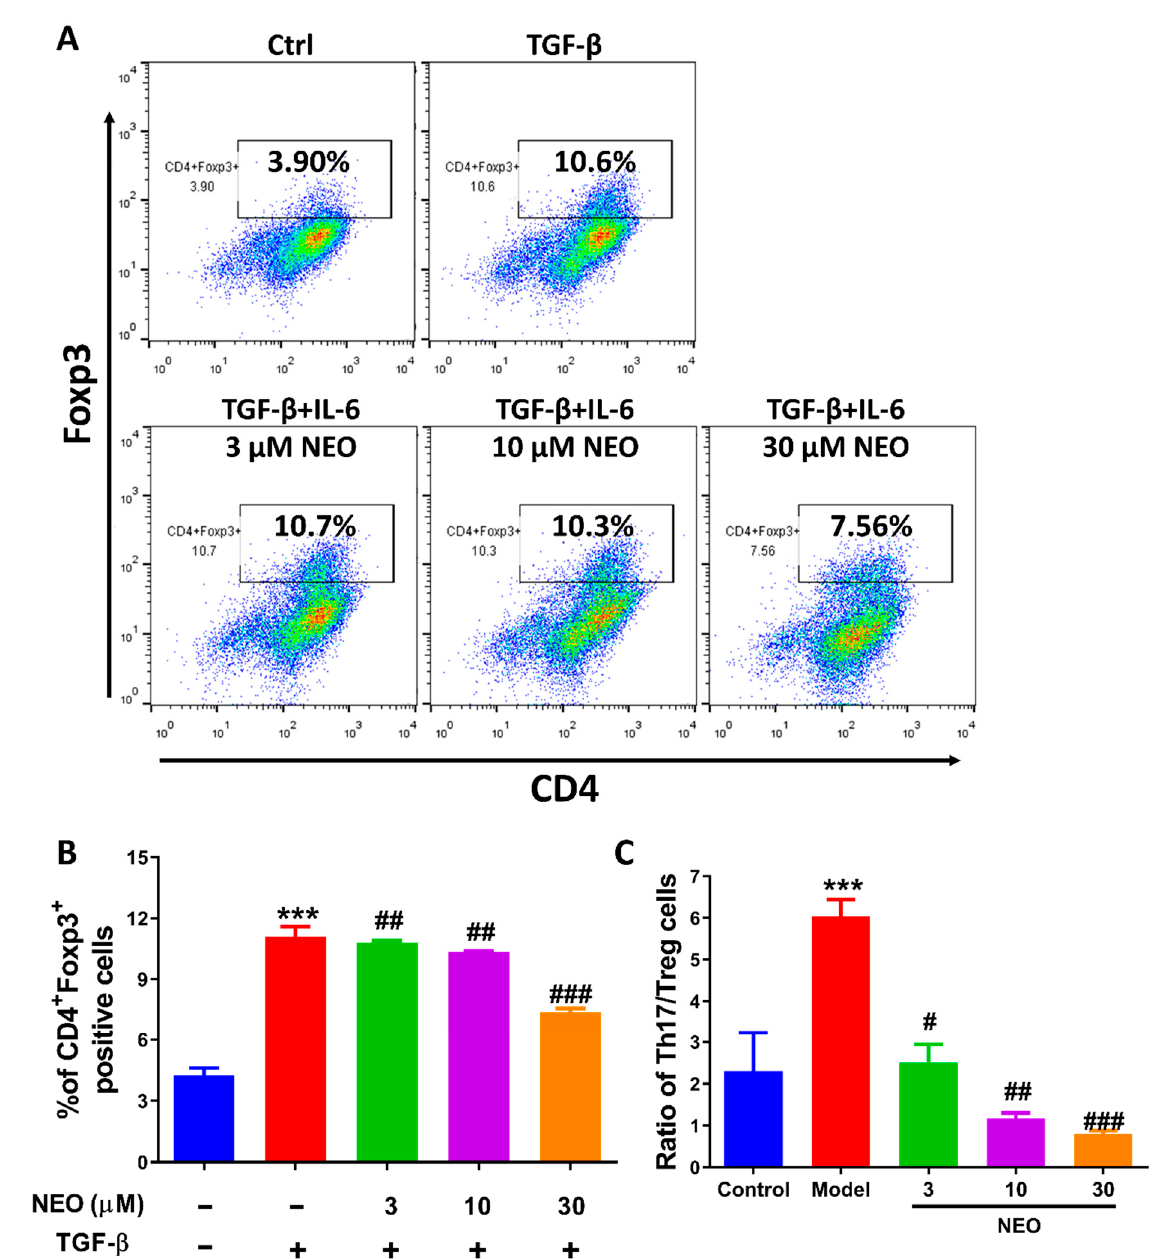
Figure 7. Influence of NEO on Treg cell differentiation. ( A , B ) Effect of NEO on CD4 + Foxp3 + cell population. ( C ) Recovery ratio of Th17/Treg cells caused by NEO. The results represent three independent experiments. *** p < 0.001 indicated that the differences were statistically significant vs. control group; whereas, # p < 0.05, ## p < 0.01 and ### p < 0.001 declared statistically significant differences vs. TGF- β group (n = 3).